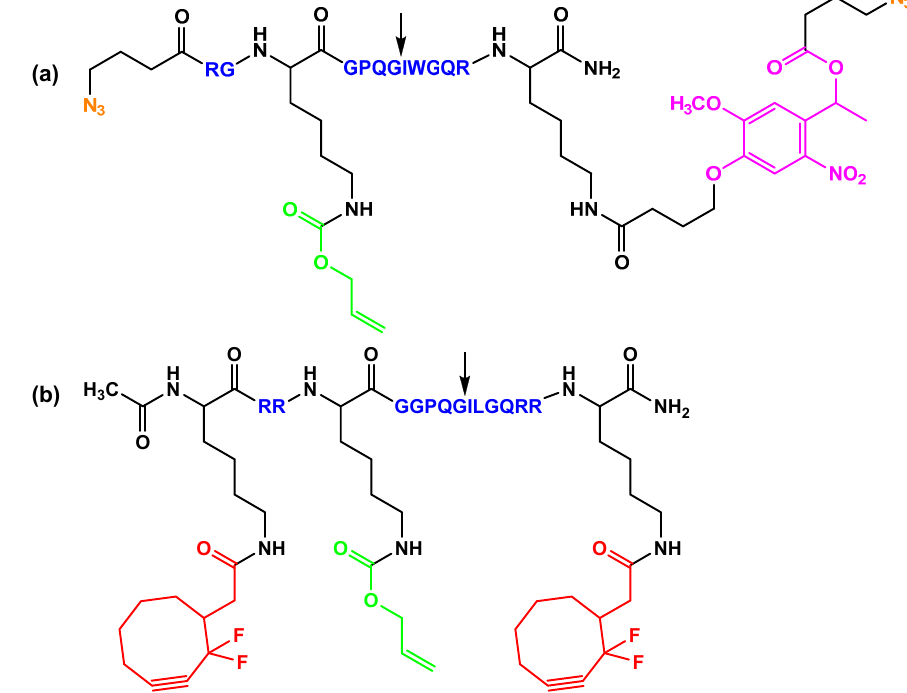
Figure 6. Enzymatically degradable peptide-based macromers with different combinations of functional moieties. An arrow indicates the enzymatic degradation site in the peptide sequence. ( a ) Peptide with photodegradable o -NP ester (magenta) and functional moieties for thiol-ene addition reactions (green) and azide-alkyne cycloaddition chemistry (orange) [137]; ( b ) Peptide with functional moieties for thiol-ene addition reactions (green) and strain-promoted azide-alkyne cycloaddition chemistry (red) [104].